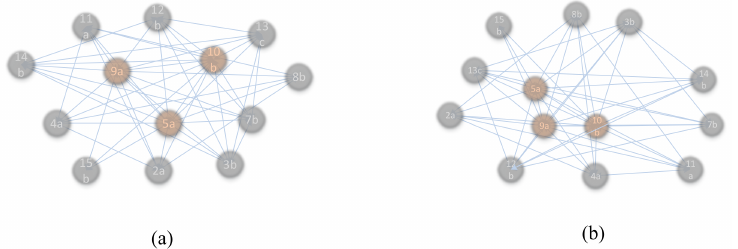
Figure 10. Safety risk complex network of prefabricated building hoisting. ( a ) A Complex network of coupled system in a high risk state; ( b ) a complex network of coupled system in an extremely high risk state.